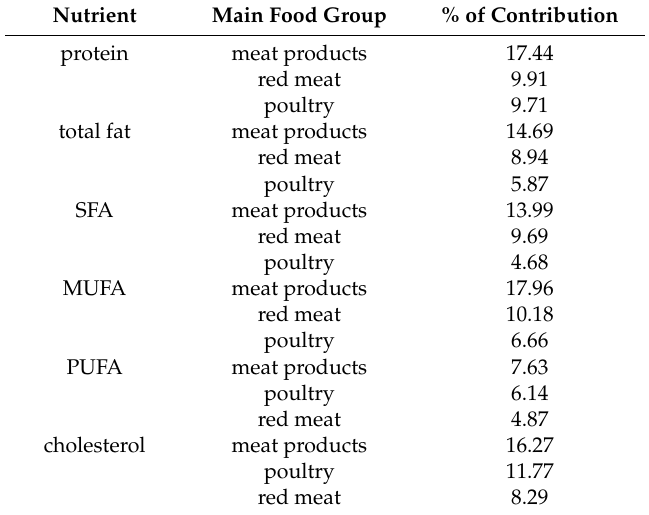
Table 4. Main food groups as the sources of protein, total fat, SFA, MUFA, PUFA and cholesterol contribution to the average Polish